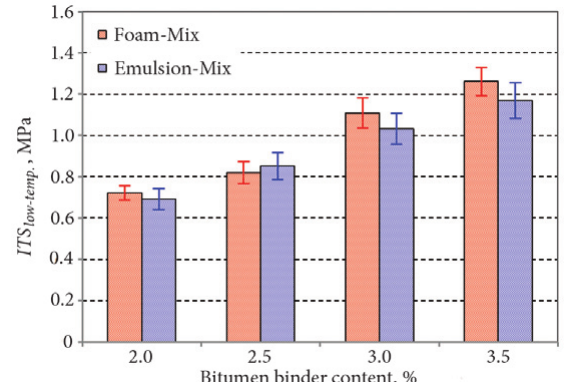
Fig. 7. Indirect tensile strengths ( ITS low-temp. ) of road base mixes after curing at –2 °C according to PANK 4302